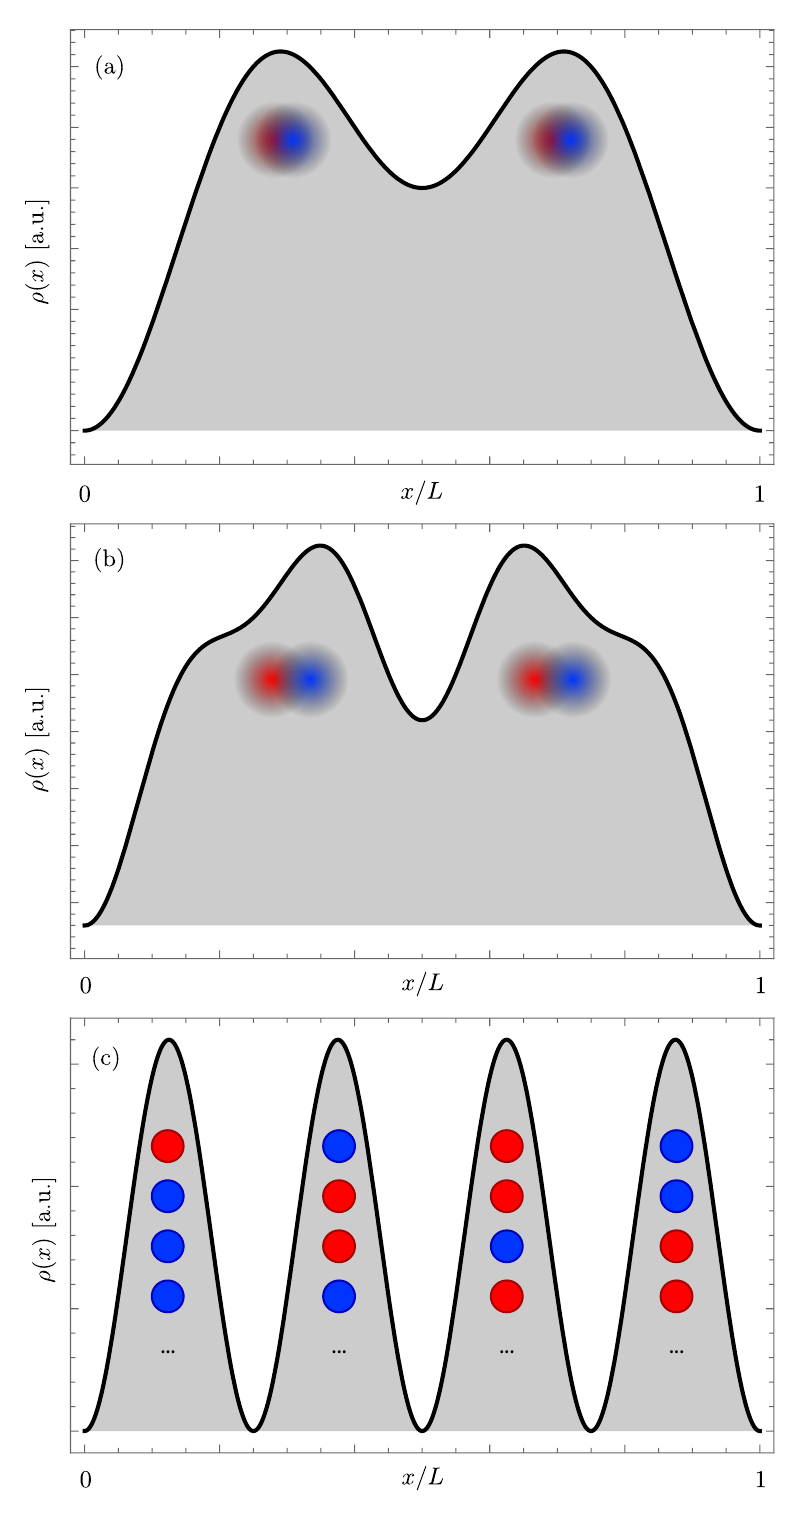
Figure 1. The transition from the Friedel to the Wigner regime for the ground state density profile ρ 0 ( x ) , for the case of 2 N = 4 particle—see text for details. ( a ) For non-interacting electrons, Friedel oscillations occur, characterized by N = 2 density peaks; ( b ) for moderate electrons, additional peaks appear but with a small peak-valley ratio; ( c ) for strong interactions 2 N peaks in the density develop. Here, red (blue) dots represent electrons with spin up (down), a blurred dot denoting delocalized electron wave functions, while a sharp dot implying strongly localized electrons. In panel ( c ), some of the 16 possible degenerate spin configurations are shown as an